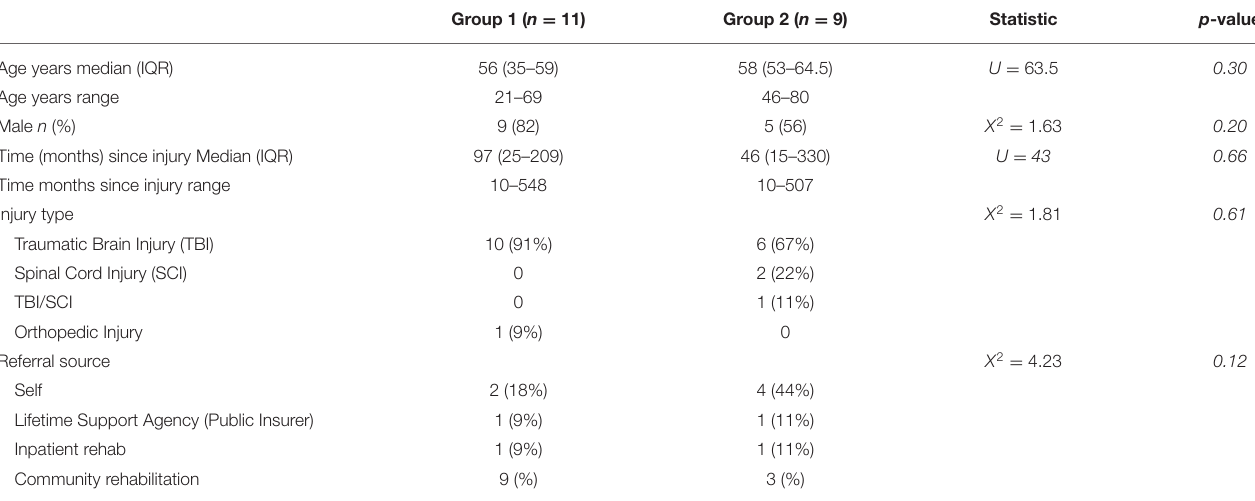
TABLE 2 | Baseline comparison of demographics between